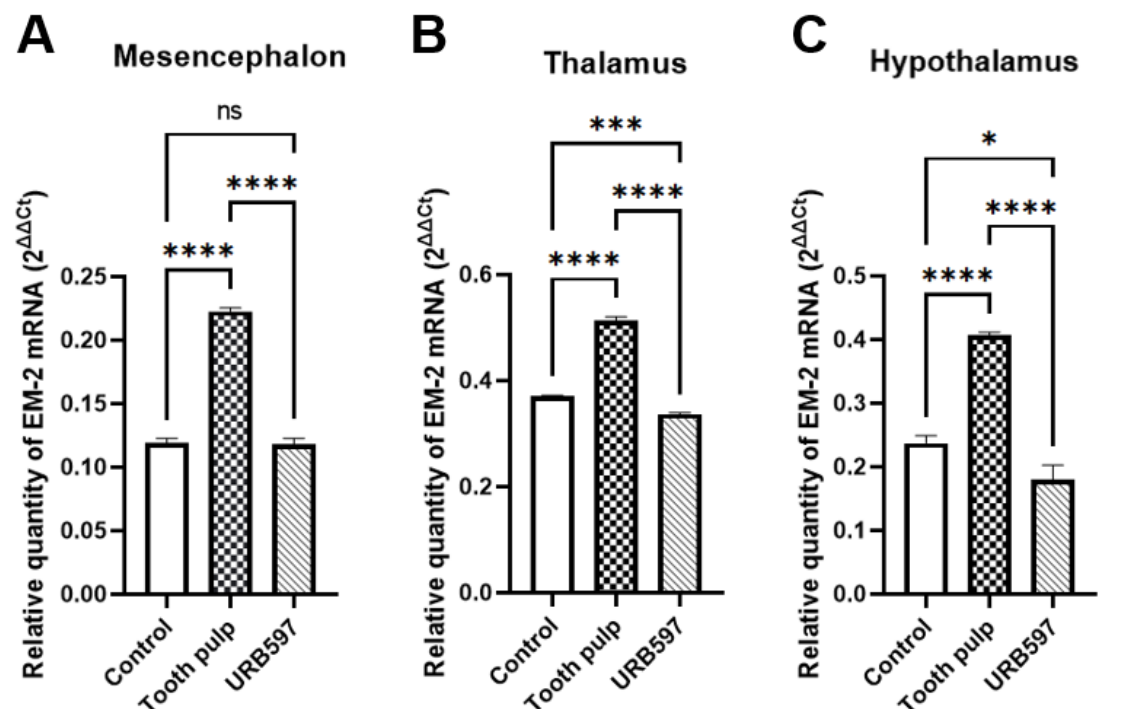
Figure 4. Quantitative RT-PCR analysis of EM-2 mRNA expression in ( A ) mesencephalon, ( B ) thal- amus and ( C ) hypothalamus induced by tooth pulp and URB597 treatment. The data represent mean ± SEM of 6 rats per group. Statistical significance was assessed using one-way ANOVA and a post hoc multiple comparison Tukey test. Asterisks denote significance level (* p < 0.05, *** p < 0.001, **** p < 0.0001, ns — not statistically significant).